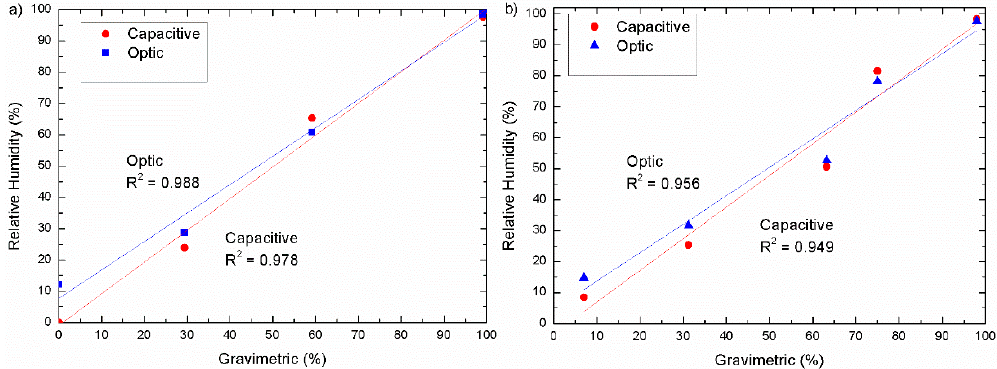
Figure 9. Capacitive and optical sensor’s regression slopes: ( a ) Soil1 and ( b ) Soil2.